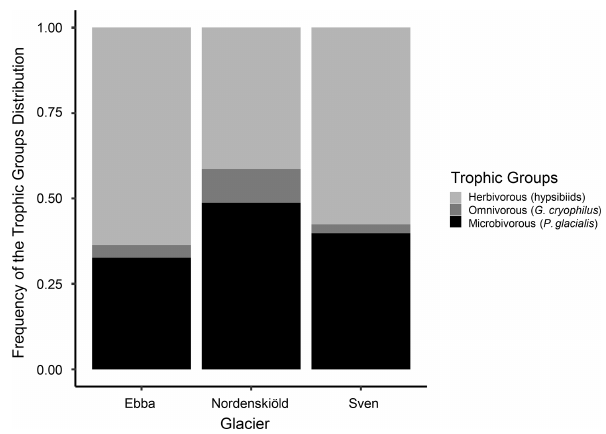
Figure 4. Bar plot visualization of tardigrades’ trophic-group rela- tive distribution among